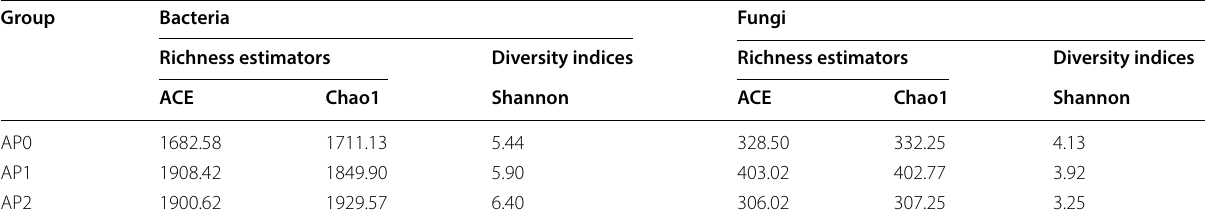
Table 1 Microbial richness and diversity of rhizospheric soil continuously cropped Andrographis paniculata